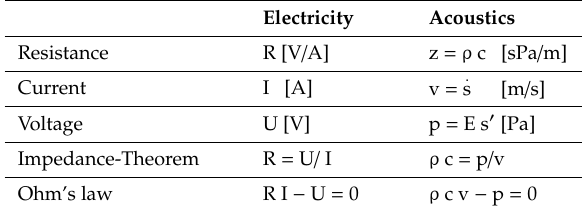
Table 1. Impedance theorem and Ohm’s law in electricity and